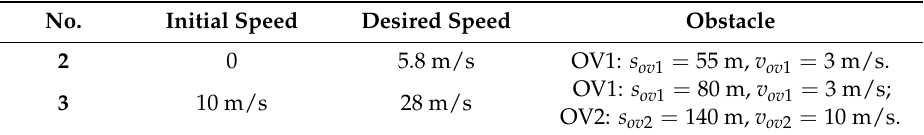
Figure 8. SCENARIO 1. ( a ) Curvature. ( b ) Desired speed. Table 2. Road parameters of SCENARIO 2 and 3. Table 2. Road parameters of SCENARIO 2 and 3.